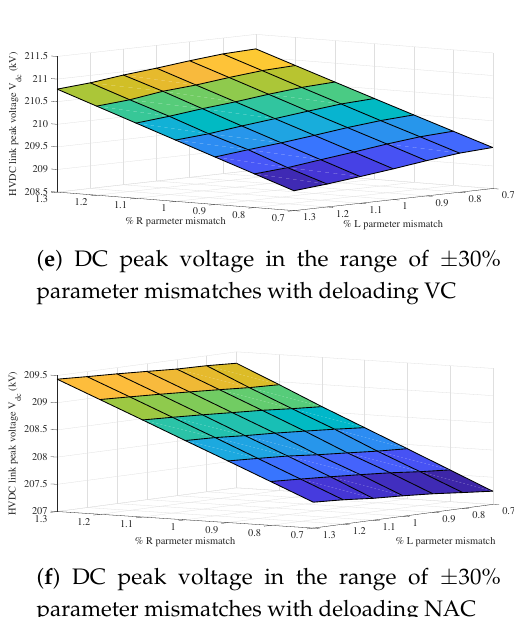
Figure 11. System responses obtained with 0.3 s duration of 30% voltage sag at onshore AC grid with DC link parameter